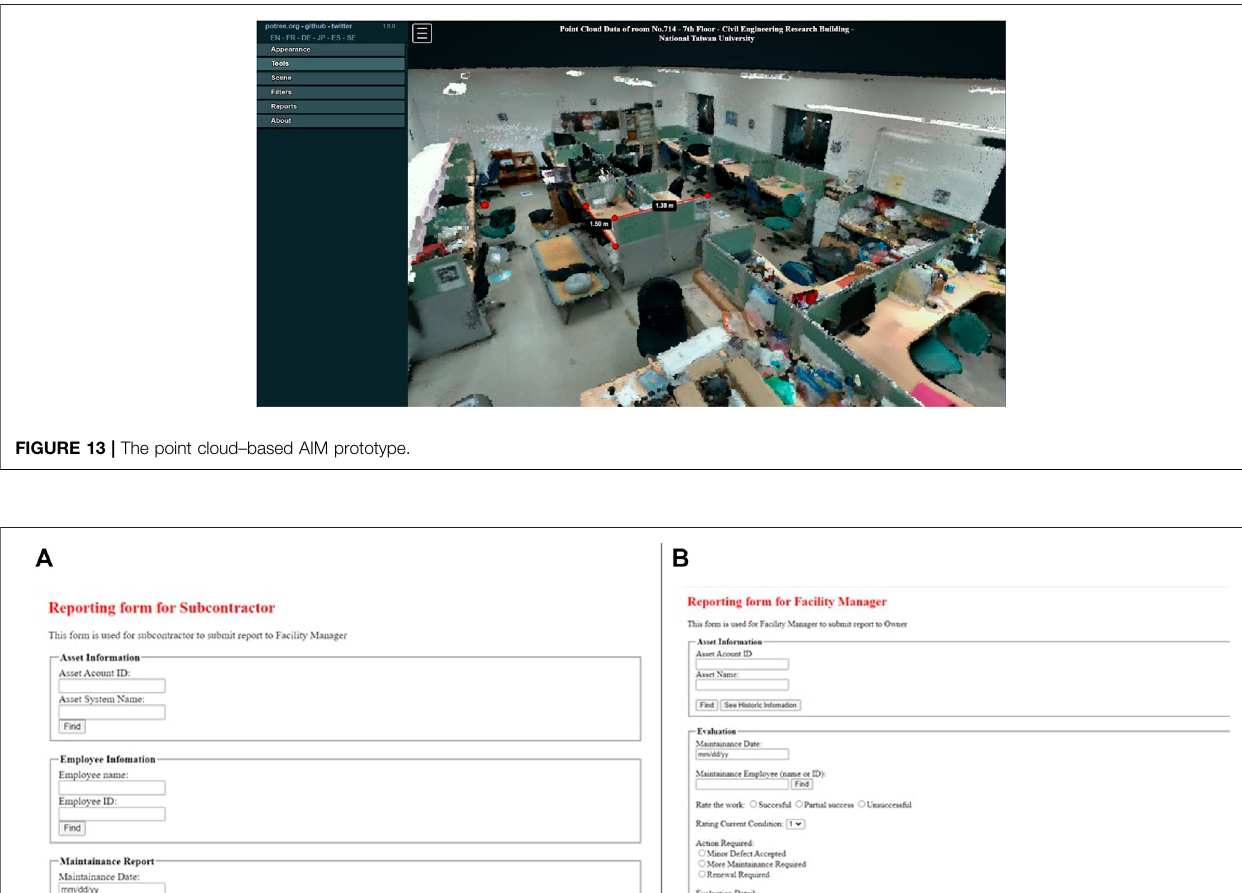
Frontiers in Built Environment |